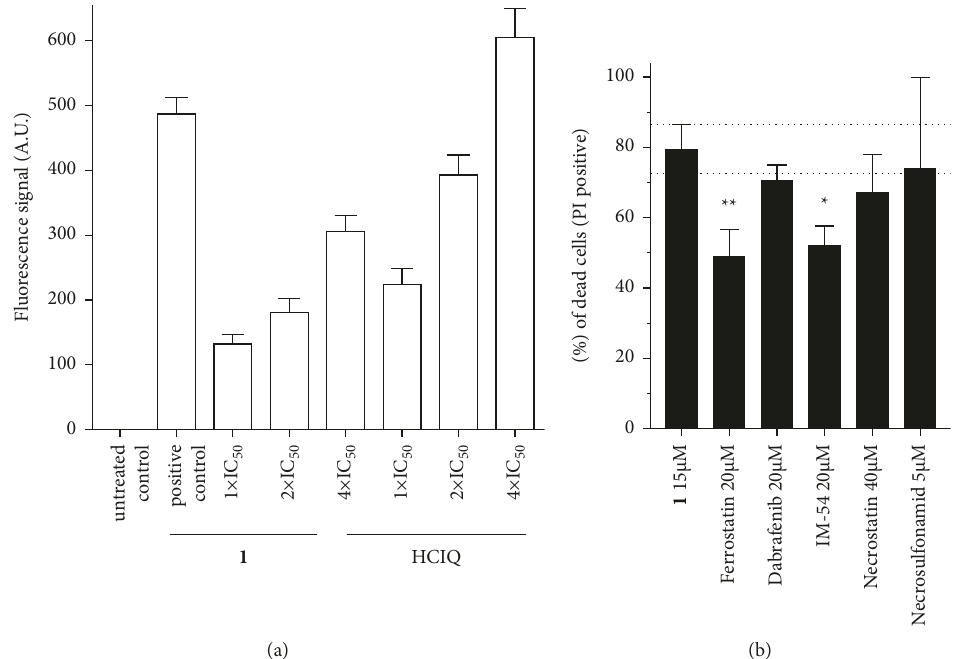
Figure 4: Flow cytometric analysis of the mechanism of cell death after the treatment with 1 in RD cells: (a) Quantitative evaluation of fluorescence signal from Cyto ID Autophagy Detection reagent. Cells were treated with the mixture of 1 μ M rapamycin + 100 μ M chloroquine (positive control), 1 or HClQ at the concentrations corresponding to one-, two-, or fourfold IC 50 , 72h for 24h. The bars represent the arithmetic mean of fluorescence signal SEM, n 3. Fluorescence signal from untreated cells (negative control) was sub- (cid:29) tracted. (b) Graphical representation of dead cell population (%) when treated with 1 in the absence and presence of ferrostatin (20 μ M), dabrafenib (20 μ M), IM-54 (20 μ M), necrostatin-1 (40 μ M), and necrosulfonamid (5 μ M), after 72h coincubation. Error bars represent ± standard deviations, n 3. The symbols ( and ) denote significant differences ( p 0 . 05 and p 0 . 01, respectively) from the sample (cid:29) incubated with 1 in the absence of the inhibitor. ∗ ∗∗ < <